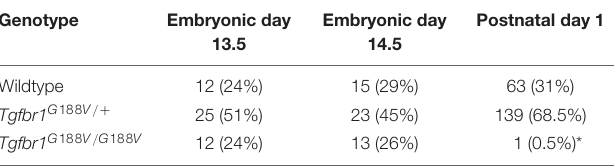
TABLE 2 | Number of mice with each